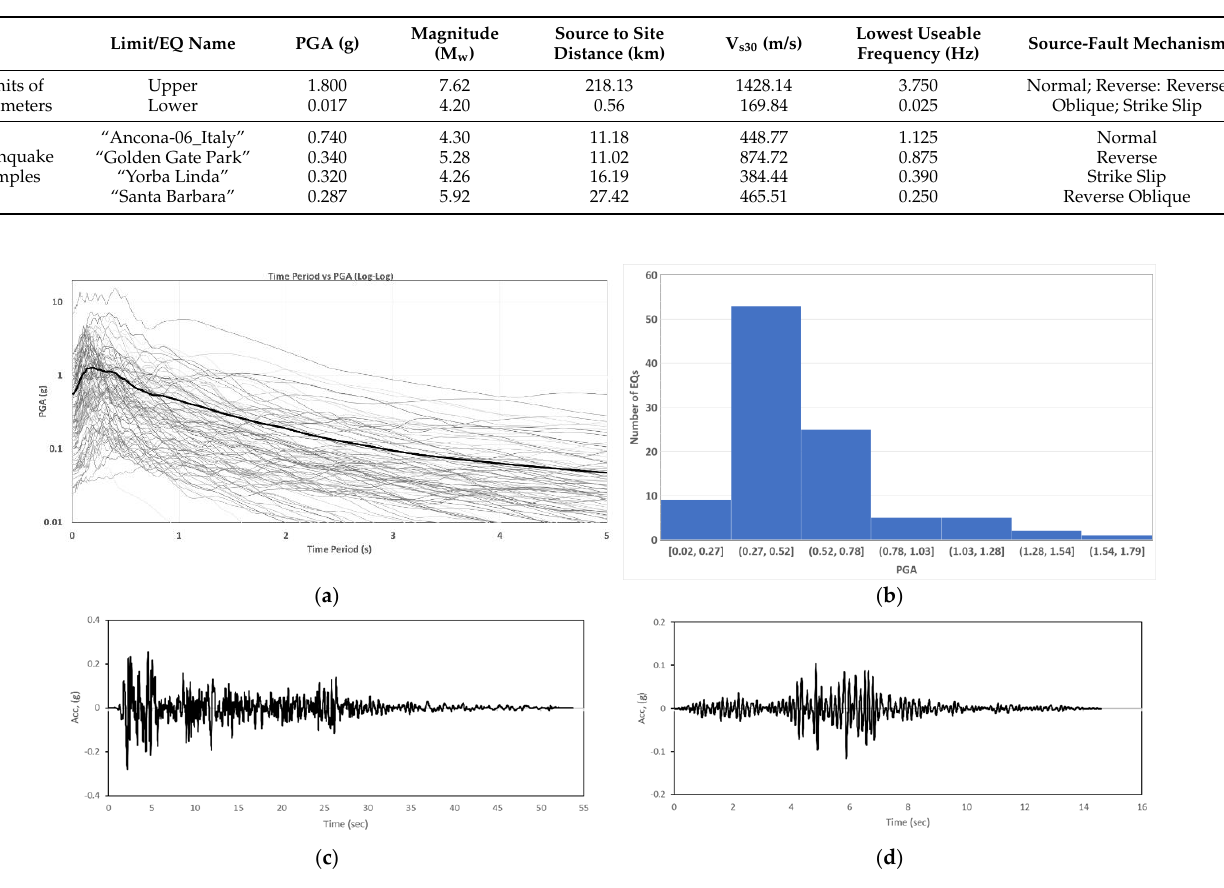
Table 2. Characteristics of the samples from 100 EQs used in NLTHA.